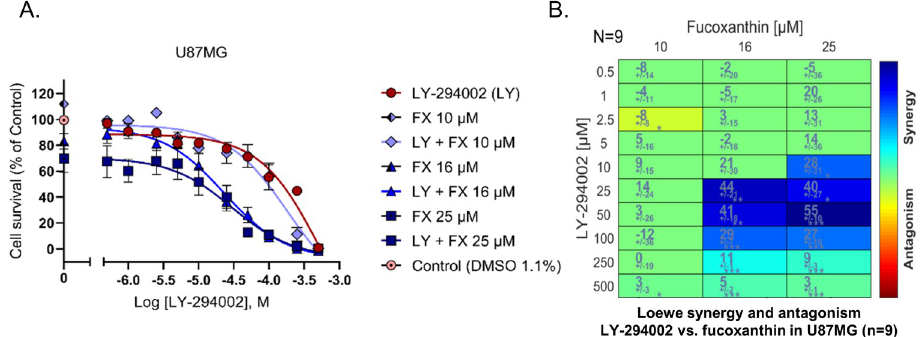
Fig 6. LY-294002 and fucoxanthin are synergistic. A) Dose response curves of LY-294002 and fucoxanthin using three concentrations of fucoxanthin (10 μ M, 16 μ M and 25 μ M) with 10 separate concentrations of LY-294002. B) Loewe synergy analysis.